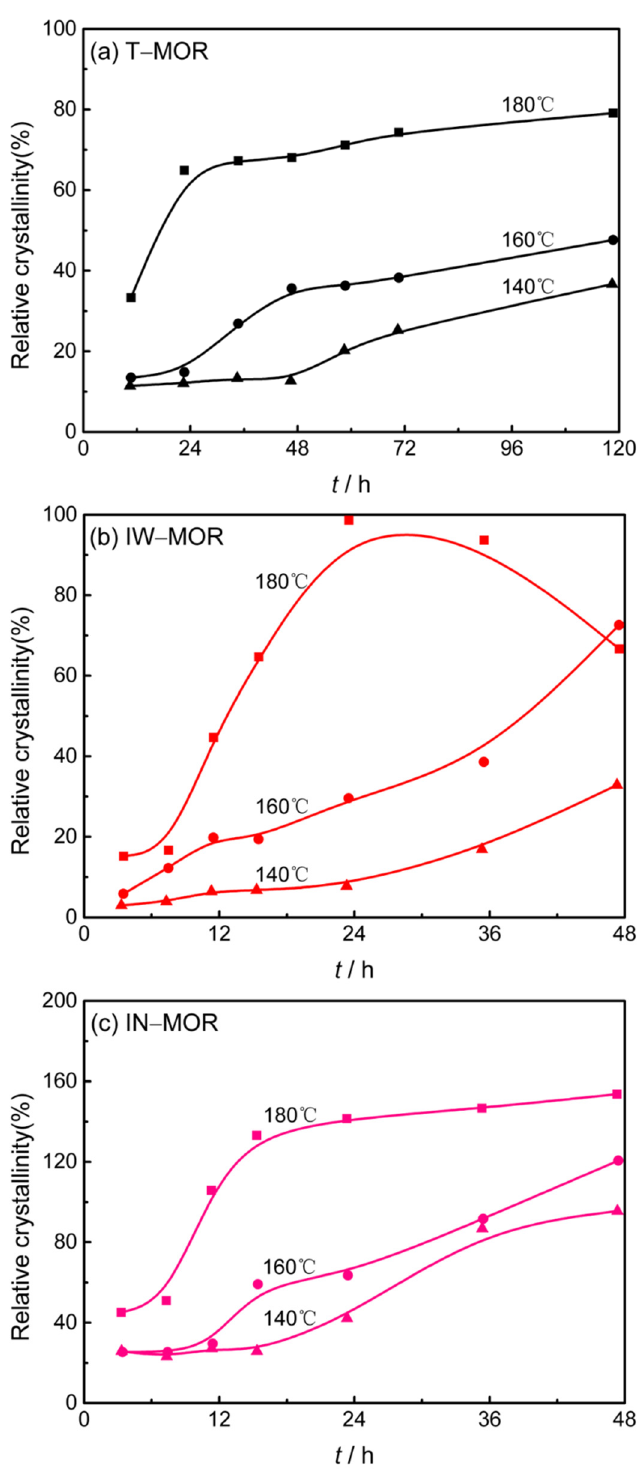
Figure 7. The relative crystallinity kinetics of MOR samples intensities, as estimated from the XRD. ( a ) T–MOR, ( b ) IW–MOR, ( c ) IN–MOR.